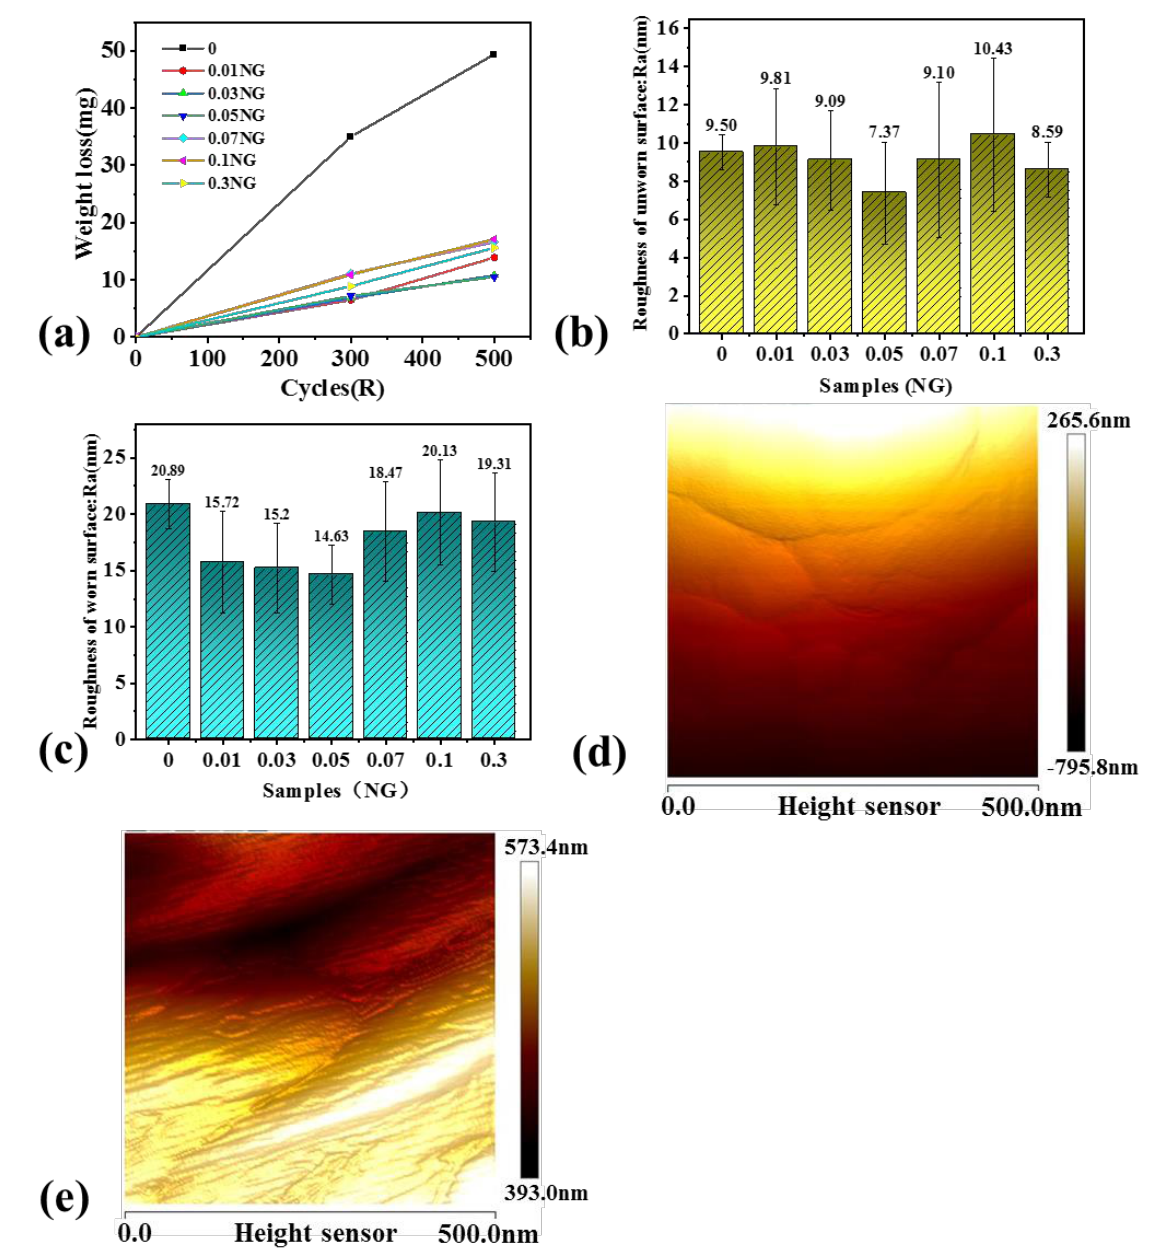
Figure 6. ( a ) Weight loss of composite coatings with different content of NGS versus abrasion cycles; roughness of ( b ) unworn surface and ( c ) worn surface of samples with different NGS contents; AFM surface height of worn surface of ( d ) 0 wt% and ( e ) 0.005 wt% NGS composite WPU coatings.